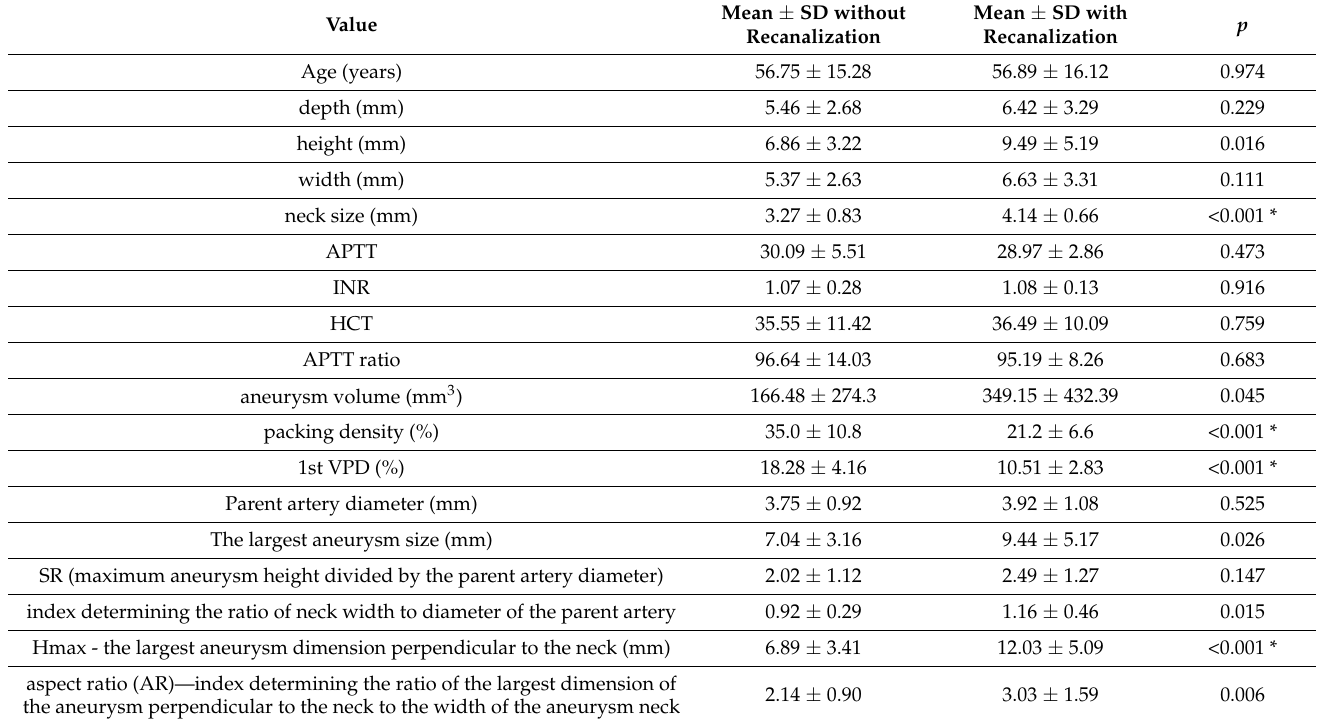
Table 4. Laboratory results, morphometric parameters, packing density, and first coil volume packing density (1st VPD) of intracranial